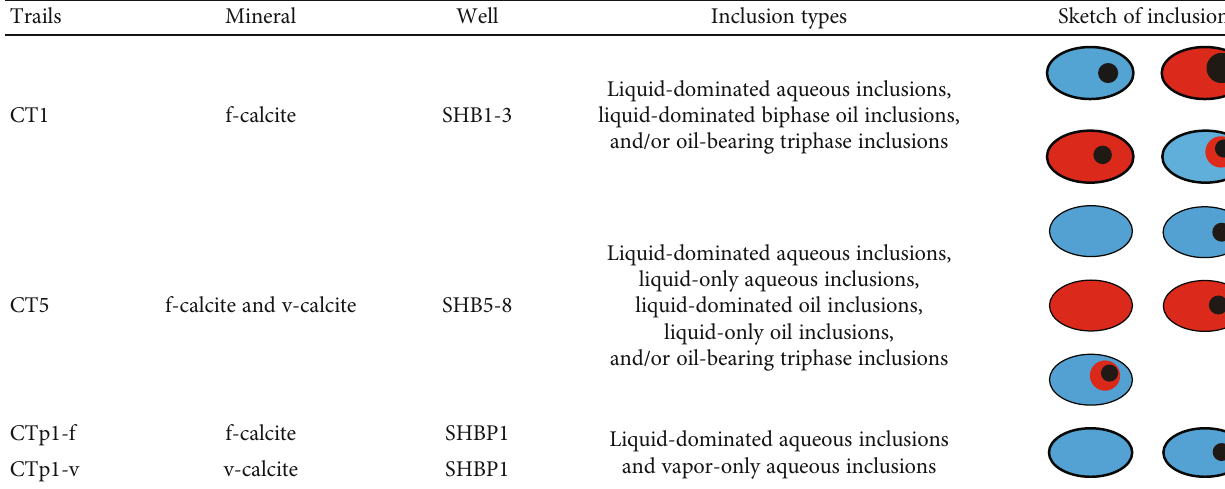
Table 1: Fluid inclusion occurrence and coexistence. The blue circles and red circles represent the aqueous inclusions and oil inclusions, respectively. The black circles represent the vapors in inclusions.